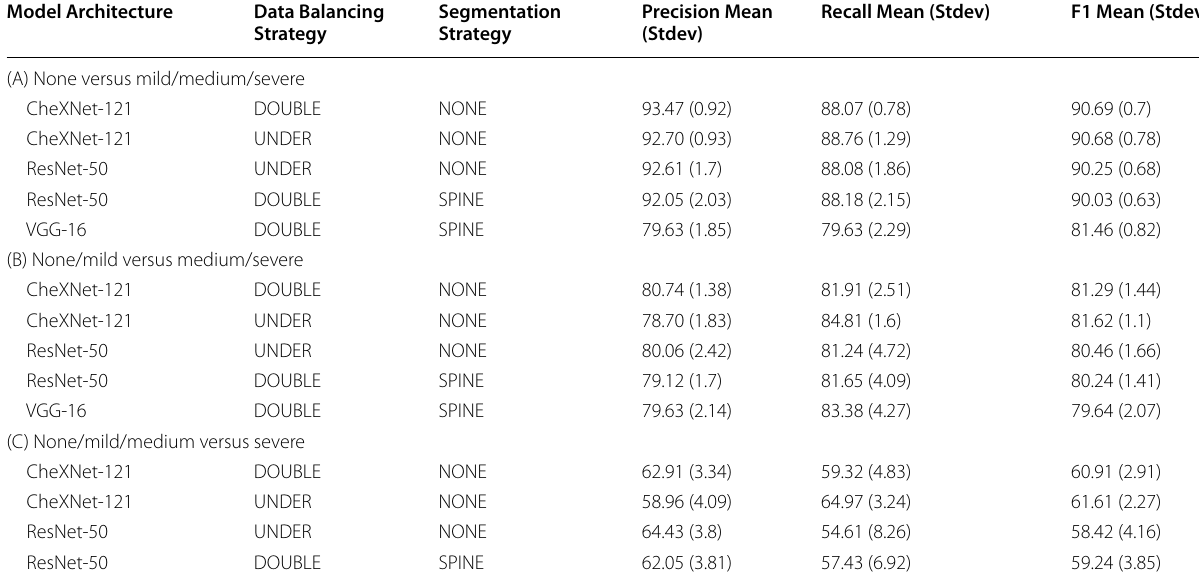
Table 5 Comparison of final models across all five folds for binary models Model Architecture